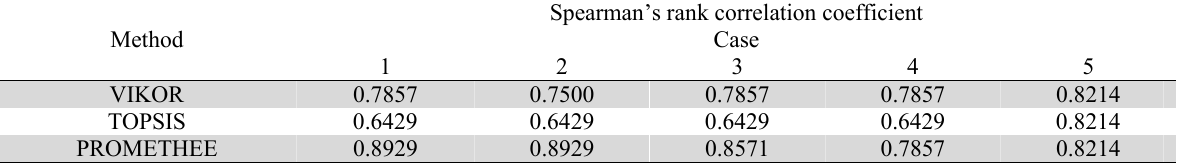
Spearman’s rank correlation coefficients for Example 3